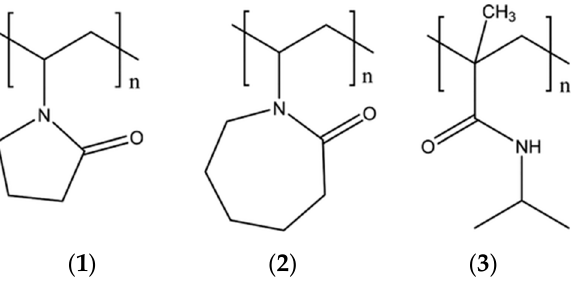
Figure 6. Kinetic inhibitors of gas hydrate formation: poly-N-vinylpyrrolidone (PVP) ( 1 ), poly-N- vinylcaprolactam (PVCap) ( 2 ), poly-N-isopropyl methacrylamide (PNIPMAm) ( 3 ). Anti-agglomerates are used in small doses of 0.1–3.0% of the volume of the aqueous